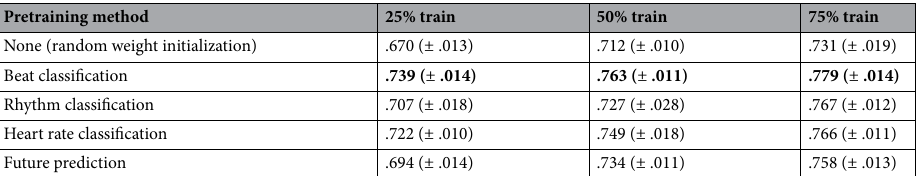
Table 2. Comparison of the pretraining methods depending on the size of the downstream train set. For each method, we report the average macro F 1 score (and the standard deviation) on our test set for the PhysioNet/ CinC Challenge 2017 7,8 . We examine 3 sizes of the train set as a proportion of the entire data set: 25%, 50% and 75% (original split). Pretraining allows models to be trained on less data and still achieve the same degree of performance as the same models that are not pretrained.